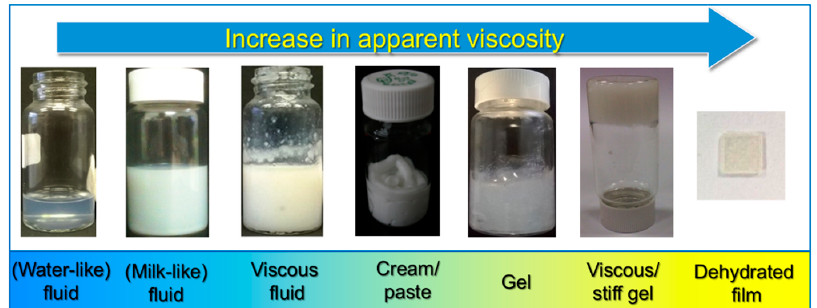
Figure 6. Apparent viscosity and virtual appearance of lipid-based systems. From left to right: liposome solution, O/W nanostructured emulsion, dense O/W water nanostructured emulsion, W/O nanostructured emulsion, bicontinuous cubic phase of a lipid, O/W water emulsion